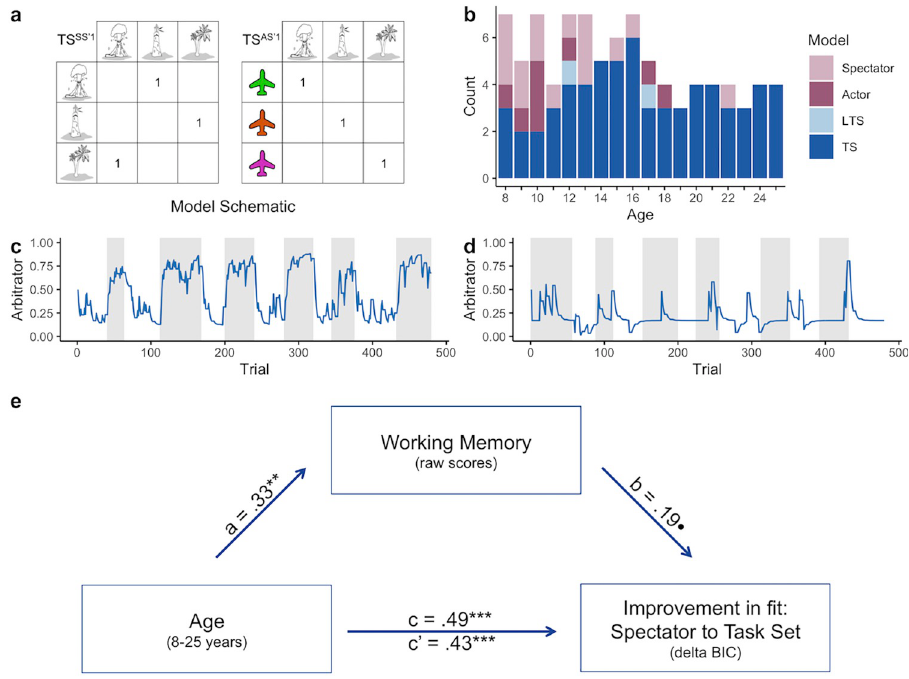
Fig 3. Model comparison and working memory mediation analysis for the best-fitting Task Set Model. (a) Task Set rules that govern how the state-state (SS’1) or state-action-state (SAS’1) models are updated after each trial. (b) The number of participants best fit by each model as a function of age. (c-d) Dynamics of the arbitrator are plotted for two example participants. Higher values reflect greater inferred controllability. Shaded areas reflect the controllable condition and white reflects the uncontrollable condition. (e) Working memory partially mediated the relation between age and improvement in quality of fit between the Spectator and Task Set model. Path a shows the regression coefficient for age-related improvements in working memory. Path b shows the regression coefficient for the influence of working memory on the improvement in model fit between the Spectator and Task Set models, while controlling for age. Path c’ and c show regression coefficients for the influence of age on improvement in fit ( Δ BIC) with and without including working memory, respectively. The following abbreviations are used: LTS: Learned Transition Structure model; TS: Task Set model. �� Denotes p < .01; ��� denotes p < .001; ● p = .068.